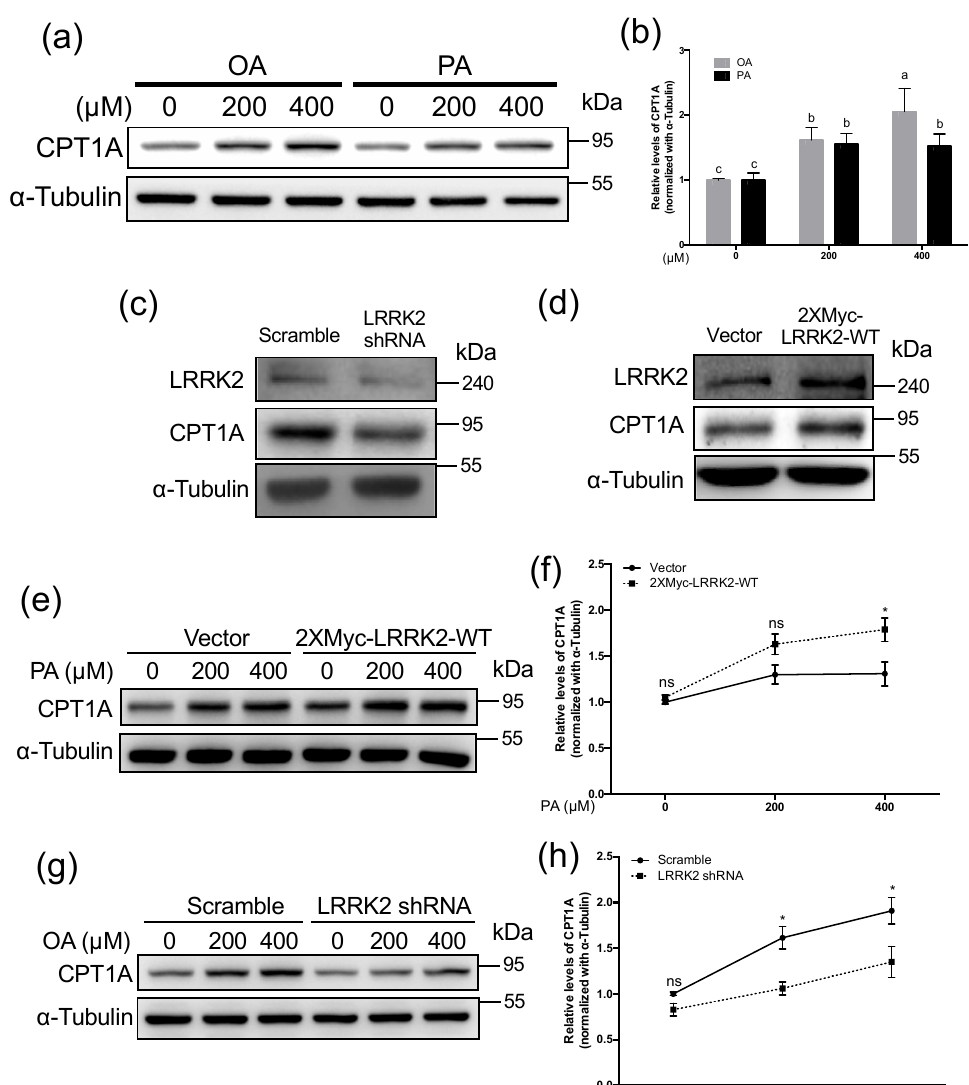
Figure 4. LRRK2 positively regulated carnitine palmitoyltransferase 1A (CPT1A) in HepG2 cells. ( a ) Western blots were used to analyze the levels of LRRK2 in HepG2 cells after treatment with 0, 200 or 400 μ M OA or PA for 24 h. ( b ) The quantified data for the LRRK2 protein levels in HepG2 cells treated with the indicated concentrations of OA or PA. ( n = 5 for each group) Data are shown as mean ± SD. Two-way ANOVA, * p ≤ 0.05. Groups with no significant difference were labeled with a common letter. ( c ) A western blot was used to analyze the protein levels of LRRK2, CPT1A and α -Tubulin in the HepG2 cells with scramble shRNA or LRRK2 shRNA and ( d ) the HepG2 cells transfected with vector control or 2XMyc-LRRK2-WT plasmid. ( e ) The levels of CPT1A after treatment with 0, 200 or 400 µ M of PA for 24 h in the vector control and LRRK2-overexpressed HepG2 cells. ( f ) The levels of CPT1A were quantitated and normalized with its levels of α -Tubulin ( n = 4 for each group). All data were further normalized to the group with 0 µ M of PA. Data are shown as mean ± SD. Two-way ANOVA, * p ≤ 0.05, ns: non-significant di ff erence. ( g ) The levels of CPT1A after treatment with 0, 200 or 400 µ M of OA for 24 h in the scramble control and LRRK2-knockdown HepG2 (detected using a western blot). ( h ) The levels of CPT1A were quantified and normalized to the sample levels of α -Tubulin ( n = 4 for each group). All the data were further normalized to the group with 0 µ M of OA. Data were shown as mean ± SD. Two-way ANOVA, * p ≤ 0.05, ns: non-significant difference. Vector: vector control; Scramble: scramble control.